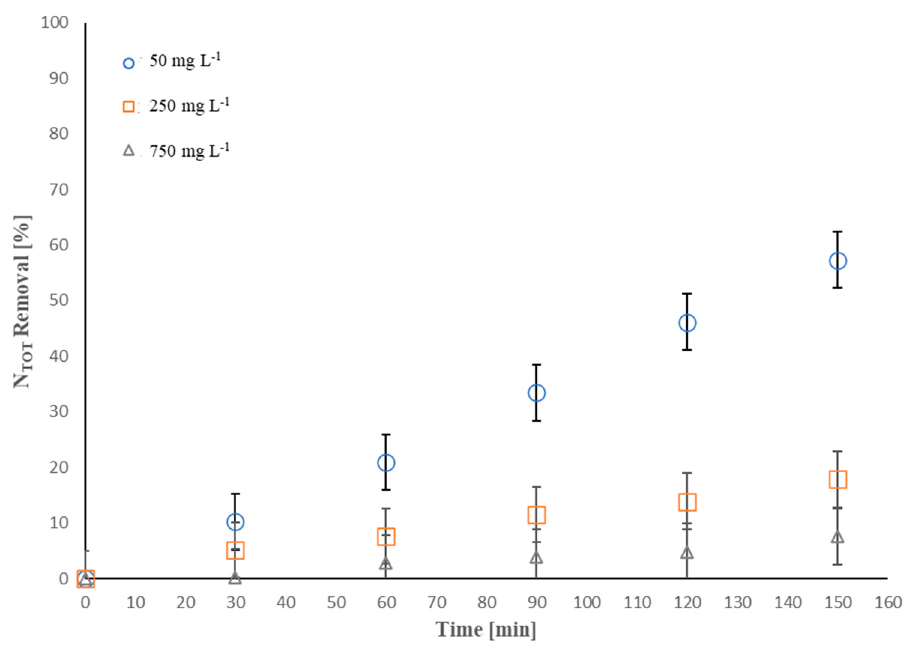
Figure 4. Effect of the initial ammonium concentration on N TOT removal (%): I = 0.15 A, electrolyte composition = NaCl, electrolyte concentration = 250 mg·L − 1 [ N TOT ] 0 = 13–200 mg·L − 1 , anode active area = 50 cm 2 .